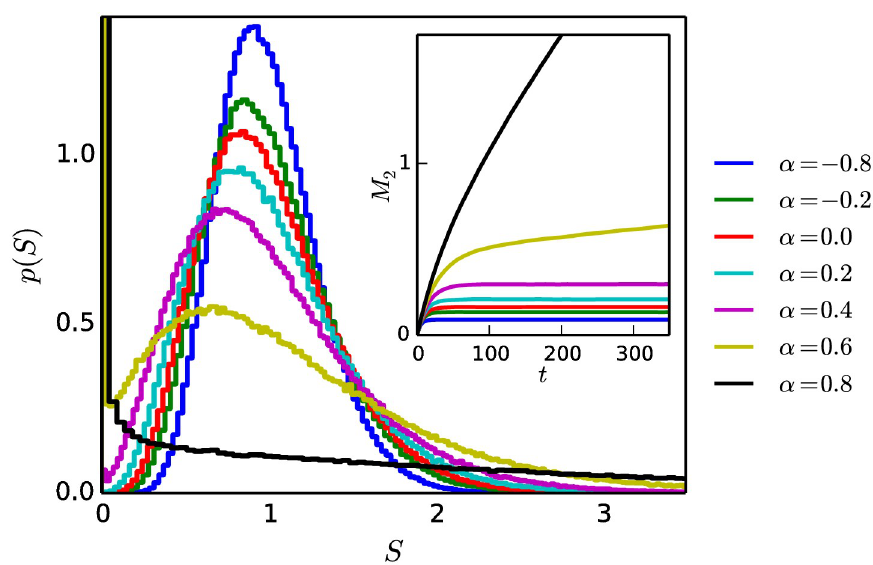
Fig 3. Shape of status distributions as functions of α , with δ = 0.14. Increasing α leads to an increase in the level of inequality of the society, while decreasing α leads to a decrease in the level of inequality. Inset: when α > 0, M 2 does not attain a plateau but continues to increase with t , at a rate that depends on α . The status distribution appears to be in steady-state for small values of α > 0 (e.g. α = 0.2 and α = 0.4 curves in the inset) when observed on short enough time scales, while they are in fact not. For larger values of α > 0 (e.g. α = 0.6 and α = 0.8 curves in the inset), the level of inequality noticeably increases on the observation timescale, indicating a runaway of the status distribution toward an end-state of maximum inequality. Distributions obtained after simulating up to time t ¼ 64^ t